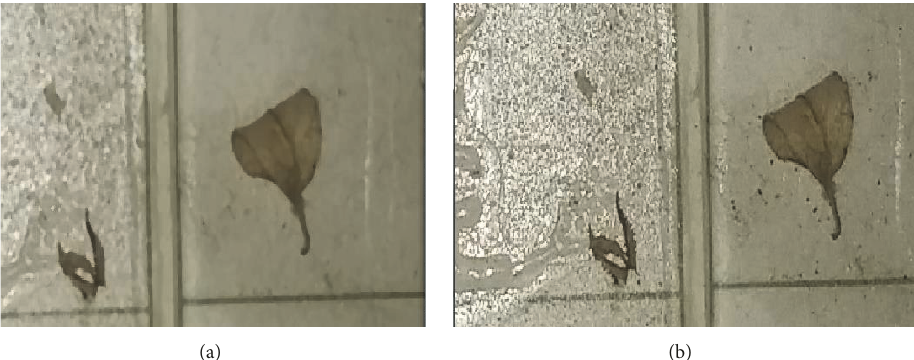
Figure 7: (b) The original image, where powder can interfere with the histogram. (a) The processed image with equalization and median filter applied; the dust particles